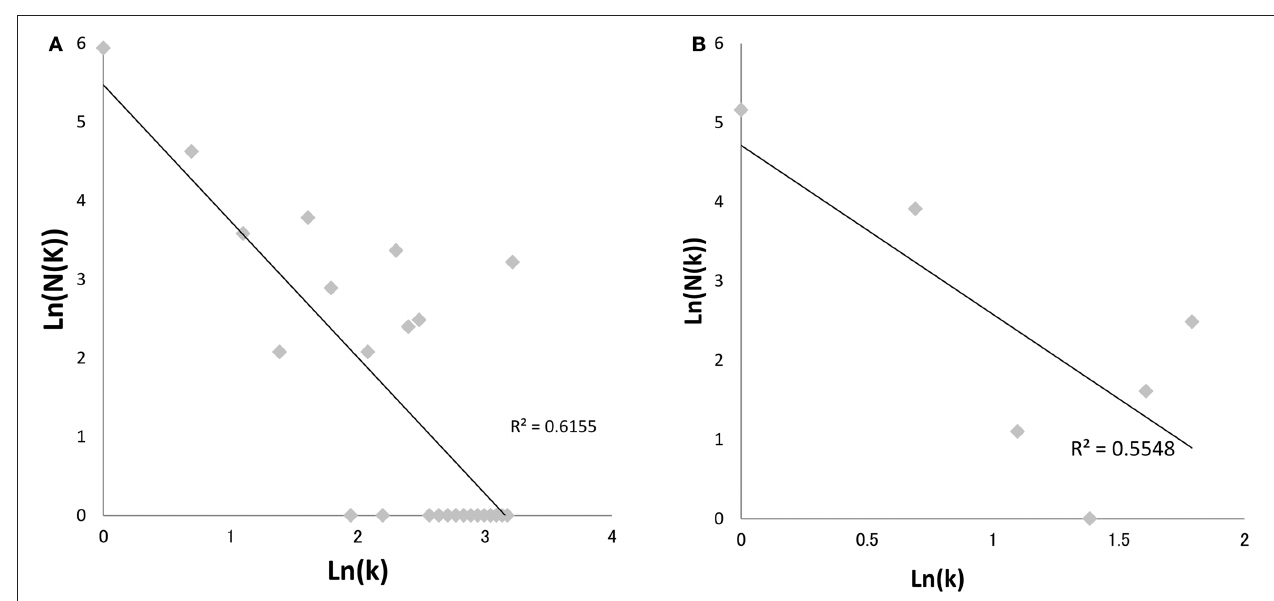
FIGURE 4 | Power-law plot of HIV-1 transmission network in Japan. The graphs depict log-log plots of the numbers of patients with k contacts [ N ( k ) ] against the number of contacts ( k ) in HIV-1 clusters of Japan subtype B (A) and CRF01_AE (B) . Regression line was calculated using the least-square method. The adjusted coefficients of determination ( R 2 ) were 0.5548 ( p = 0 . 04) and 0.6155 ( p < 0 . 01), respectively. The Neighbor-Joiningtrees were reconstructed using MEGA version